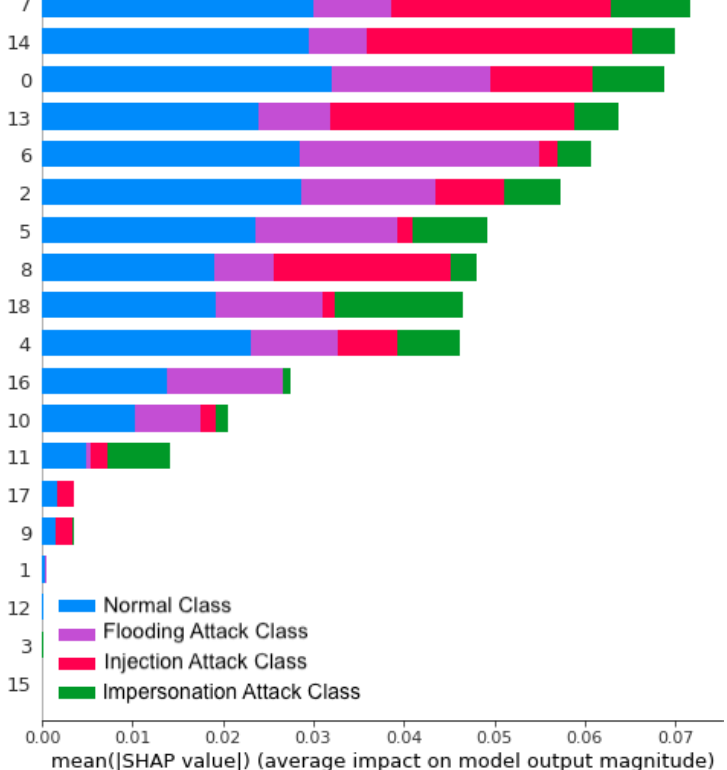
Figure 8. Influence of features on predicting the records for each